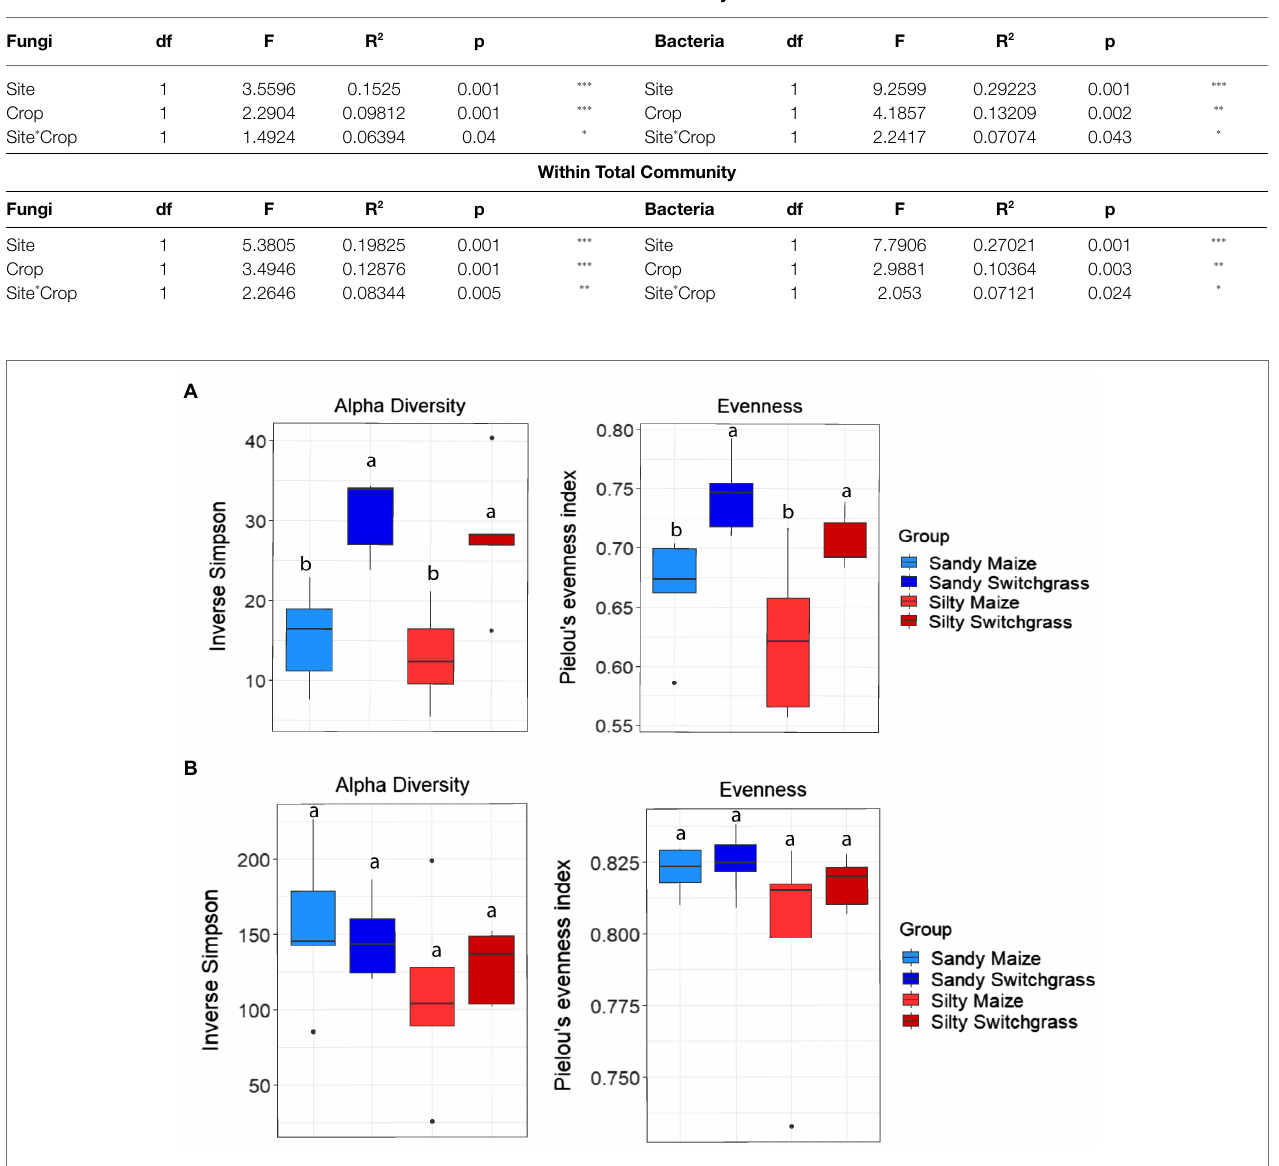
TABLE 2 | Results from permutational multivariate analysis of variance (PERMANOVA) statistical tests showing the effects of site, crop, and their interactions on Bray– Curtis distance matrices for both fungal and bacterial communities ( * p ≤ 0.05; ** p ≤ 0.01; *** p ≤ 0.001). Within Live Community